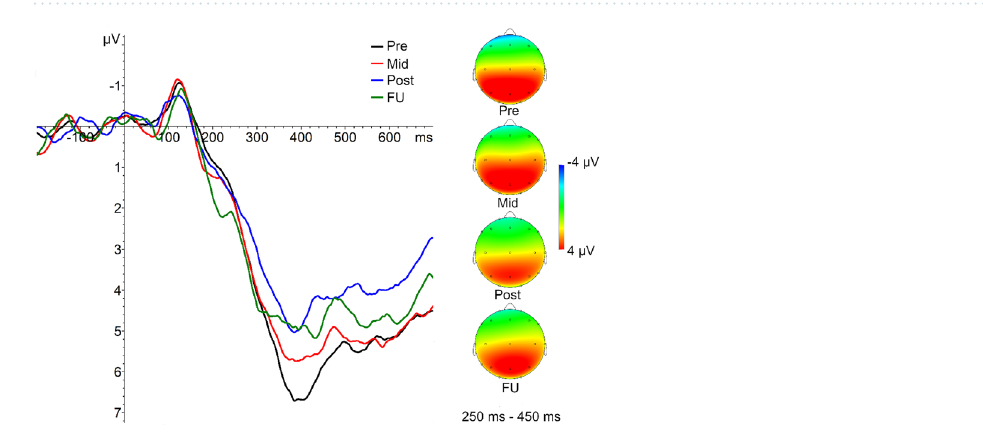
Figure 8. P300 amplitudes averaged over all feedback groups at pre-, mid-, post- and follow-up assessment at Pz and scalp topographies at time window 250–450